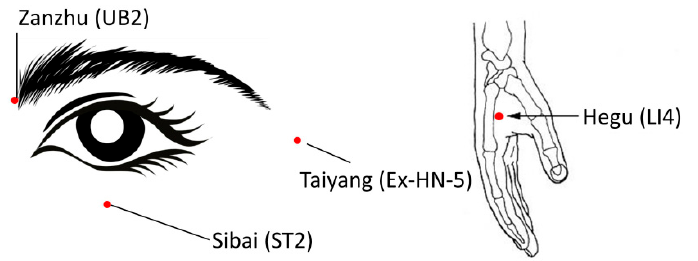
Figure 4. Points for group B (moxibustion treatment). UB2 = Urinary Bladder 2; Ex-HN-5 = Extra Point Head/Neck 5; ST2 = Stomach 2; LI4 = Large Intestine 4.